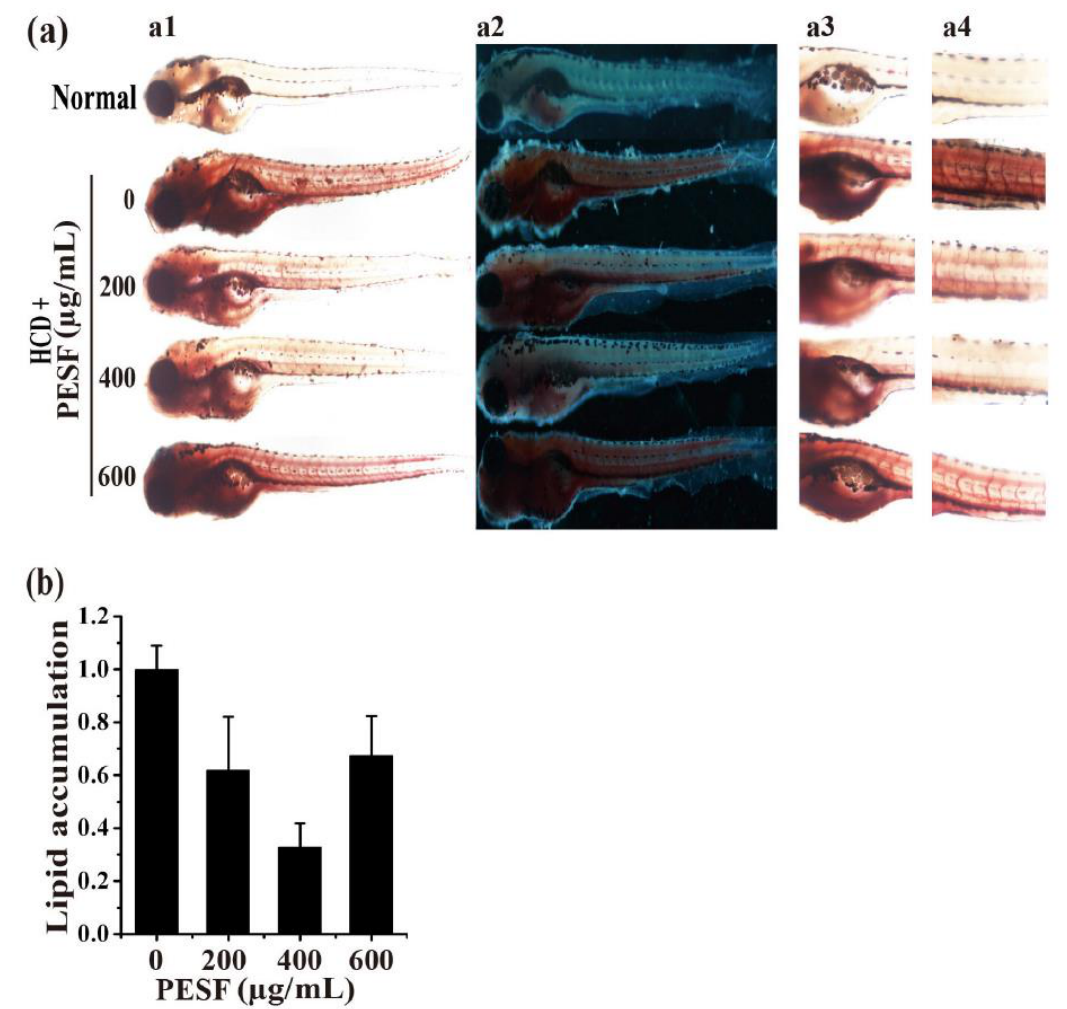
Figure 4. Lipid-lowering effect of PESF in the zebrafish hyperlipidemia model. ( a ) Representative photographs of zebrafish larval appearance with stainable lipids treated by PESF at different concentrations of 0, 200, 400 and 600 µg/mL respectively, in light (a1) and dark (a2) fields by a dissecting stereomicroscope. Stainable lipids in the zebrafish whole body (a1) (a2), gut (a3) and blood vessels (a4) decreased with PESF at concentrations of 0 to 400 µg/mL, but not 600 µg/mL. ( b ) Lipid content was normalized to the integral optical density (IOD) data through gut and blood vessel (a1) in the zebrafish larvae hyperlipidemia model.